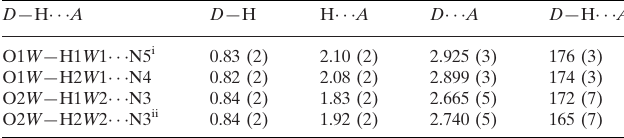
Hydrogen-bond geometry (A˚ , (cid:4)